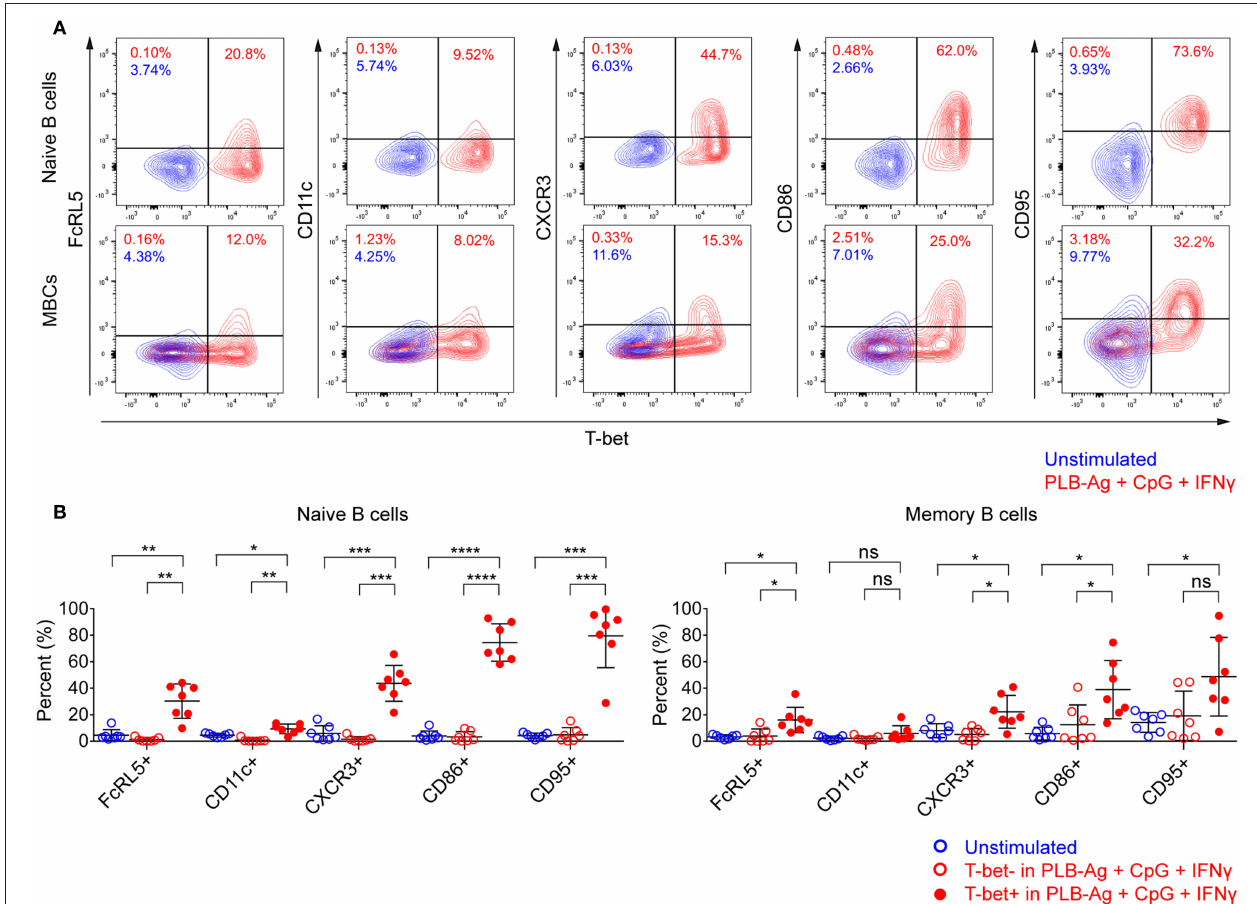
FIGURE 4 | T-bet + cells induced in vitro also express malaria-associated atypical MBC markers. Tonsil B cells were cultured in vitro for 40h unstimulated or stimulated with antigen on PLB in the presence of CpG and IFN- γ . naïve (IgD + CD10 − ) and memory (IgD − CD10 − ) B cells were analyzed by flow cytometry for the expression of T-bet and FcRL5, CD11c, CXCR3, CD86, and CD95. (A) Representative flow cytometry plots indicating expression of FcRL5, CD11c, CXCR3, CD86, or CD95 by T-bet + naïve and memory B cells. (B) Comparison of expression of FcRL5, CD11c, CXCR3, CD86, or CD95 by unstimulated or stimulated T-bet + and T-bet − naïve and memory B cells ( n = 7). Data for expression of these surface markers by T-bet + naïve and memory B cells stimulated in vitro on all the stimulation conditions is provided in Supplementary Table 2 . Data were analyzed using one-way analysis of variance (ANOVA) with Tukey’s adjustment. * P < 0.05; ** P < 0.01; *** P < 0.001; **** P < 0.0001; ns, not